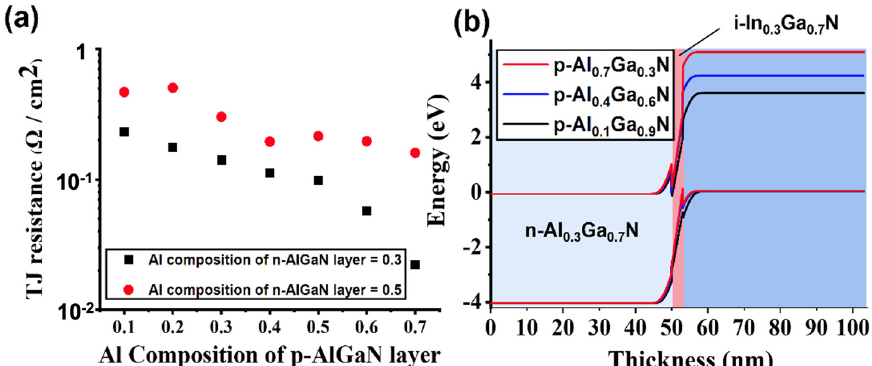
Figure 5. ( a ) TJ resistance prediction of p-AlGaN/i-In 0.2 Ga 0.8 N/n-Al 0.3 Ga 0.7 N and p-AlGaN/i- In 0.2 Ga 0.8 N/n-Al 0.5 Ga 0.5 N with different Al compositions of the p-AlGaN layer. ( b ) Band diagram of p-AlGaN/i-In 0.2 Ga 0.8 N/n-Al 0.3 Ga 0.7 N when the Al composition of the p-AlGaN layer is equal to 0.1, 0.4, and 0.7. The thickness of this i-In 0.2 Ga 0.8 N layer is 3 nm.